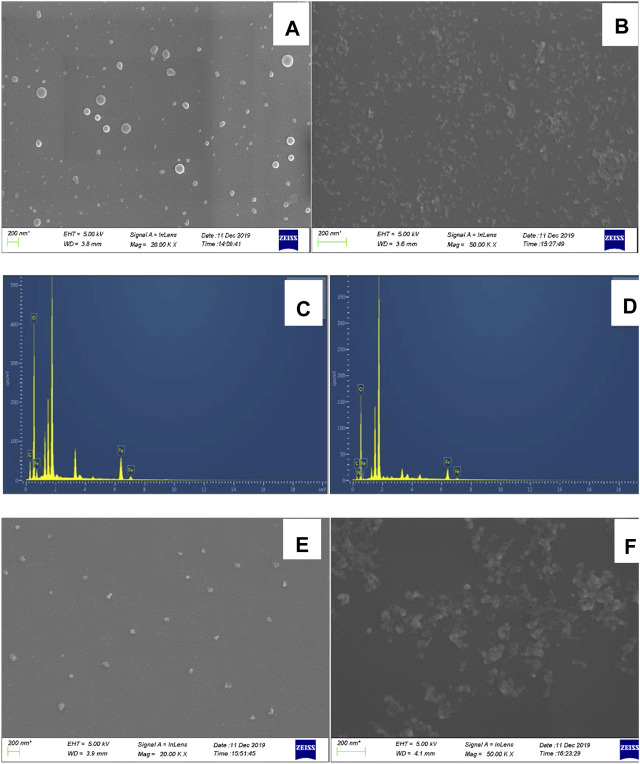
SEM and energy spectra images of analysis system. (A): SEM of CDFe; (B): SEM of CDFeN; (C): energy spectrum of CDFe; (D): energy spectrum of CDFeN; (E): Analysis system without urea, 0.08 μg/ml CDFeN+ 5.0 μmol/L H2O2+ 0.03 mmol/L TMB+ 0.51 mmol/L pH 4.07 Tris-HCl+10 nmol/L Apt+0.08 mmol/L AgNPs; (F): Analysis system with urea. E+12.5 nmol/L Urea.